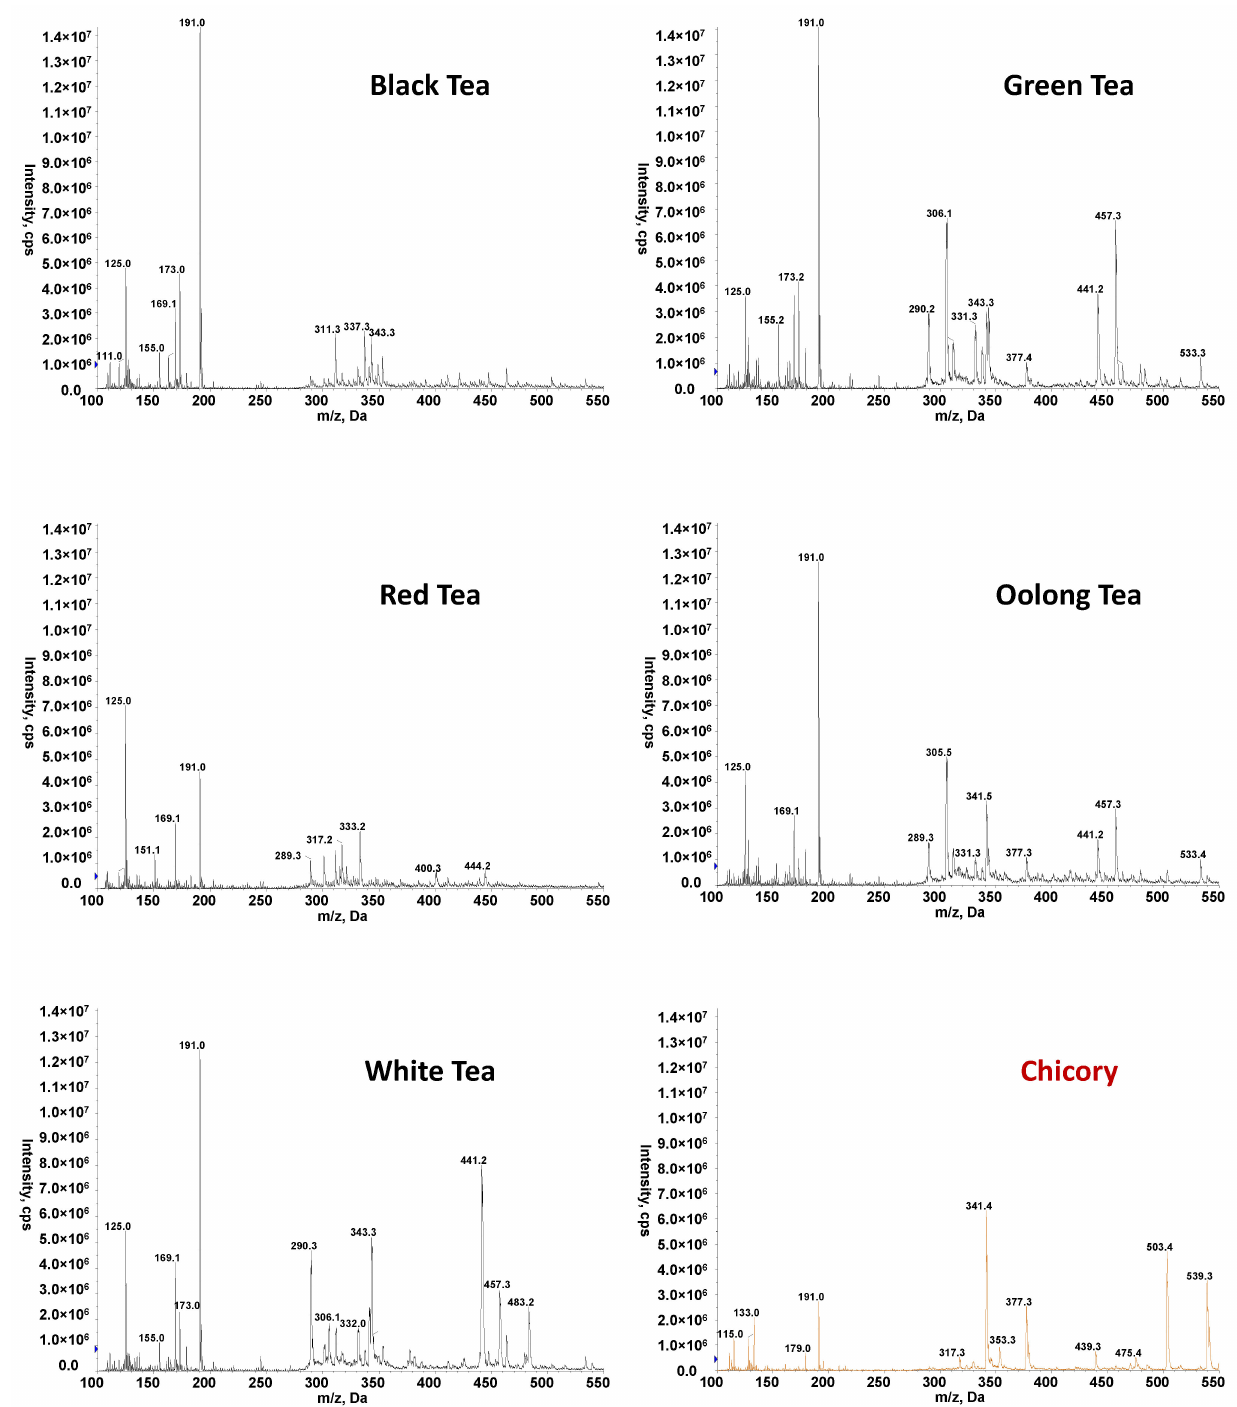
Figure 1. Non-targeted FIA-ESI( − )-MS fingerprints for selected tea and chicory